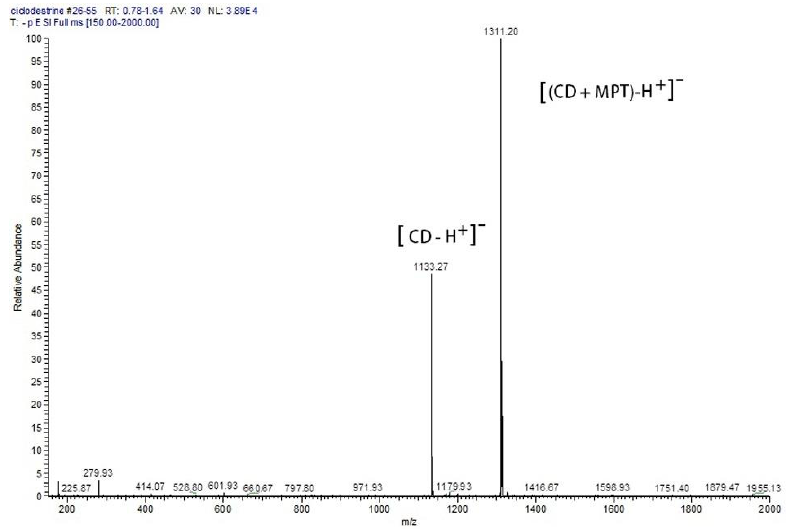
Figure 6. Electrospray negative-ion mass spectrum (ESI-MS) of a 1:1 β-CD–MPT aqueous solution that revealed a base peak corresponding to the 1:1 host–guest complex at m/z 1311 and a peak at m/z 1133 (50%) relative to uncomplexed β-CD.